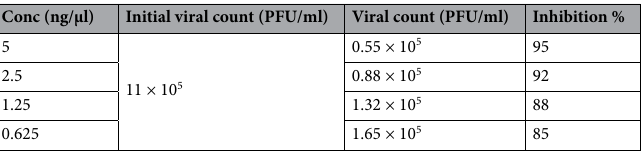
Table 1. Anti-SARS-CoV2 activity of the isolated compound (Plaque Reduction Assay).